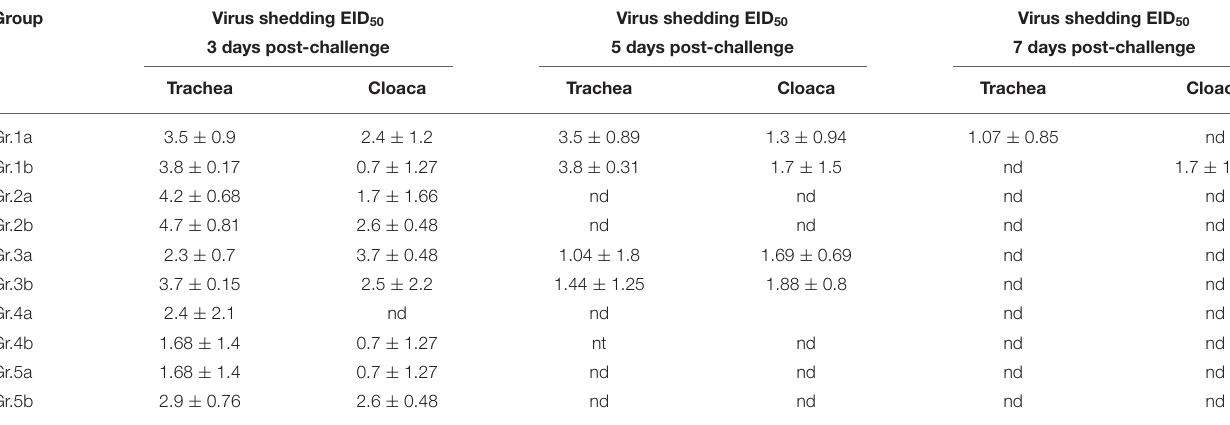
TABLE 5 | Virus shedding at 3, 5, and 7 days post-challenge, Experiment-1/2. Group Virus shedding EID 50